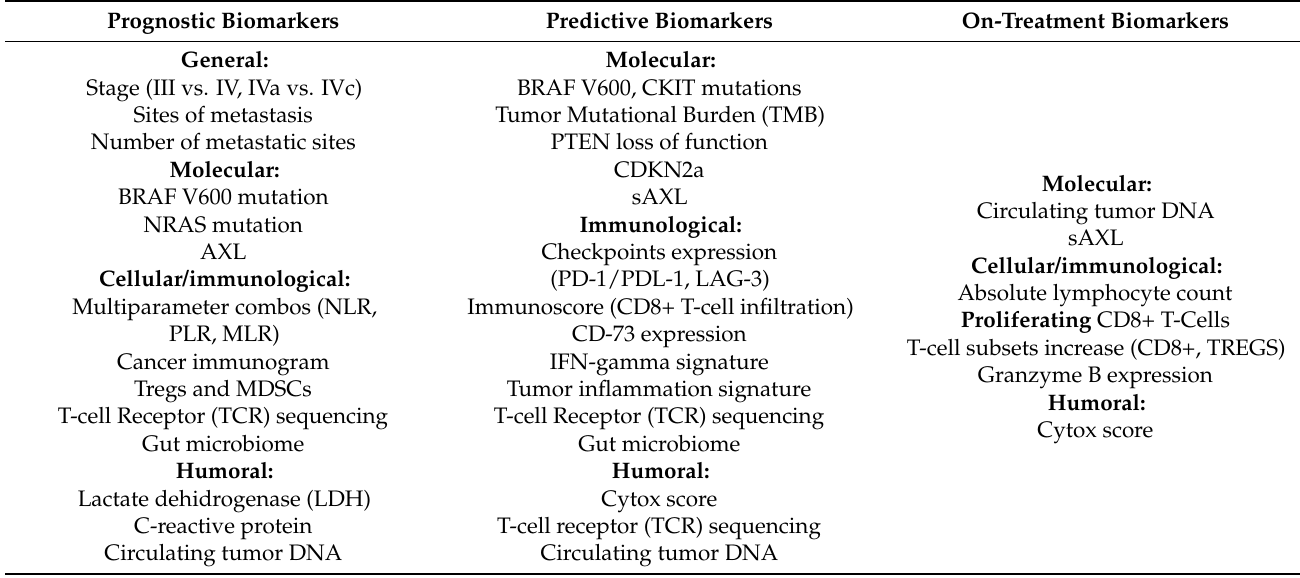
Table 1. Prognostic, predictive and on-treatment biomarkers for advanced melanoma. General markers have been distinguished by Molecular, Cellular, Immunological and Humoral